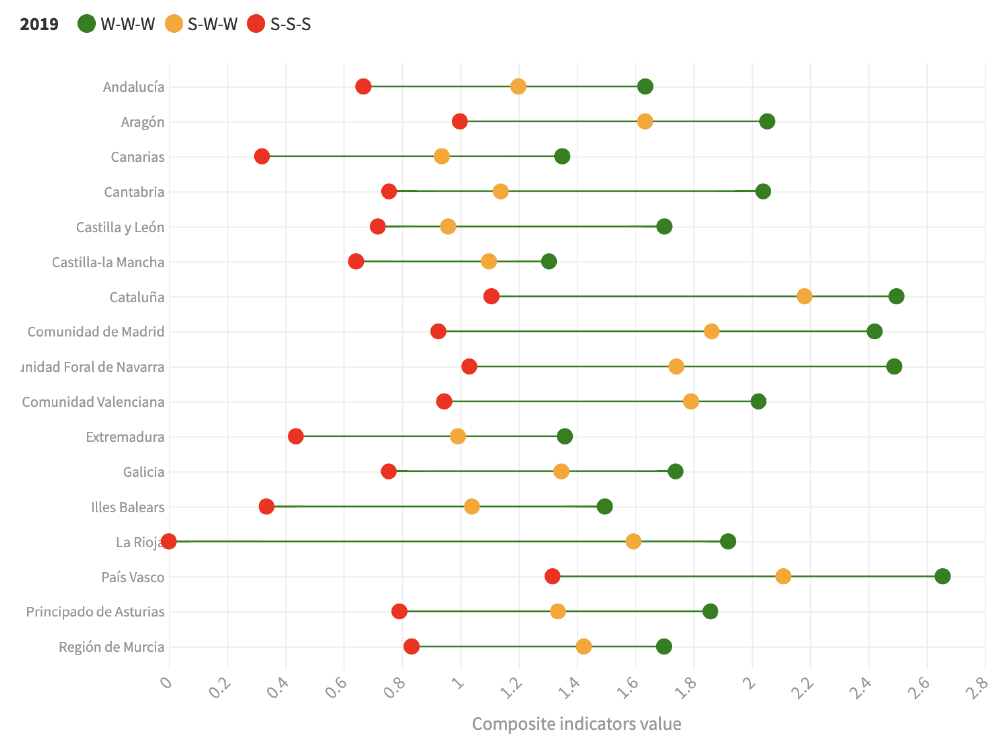
Figure 5. 2019 Spain regional innovation performance for different levels of compensability. Each line goes from the zero compensation scheme (S-S-S indicator, red) to the fully compensatory scheme (W-W-W indicator, green).